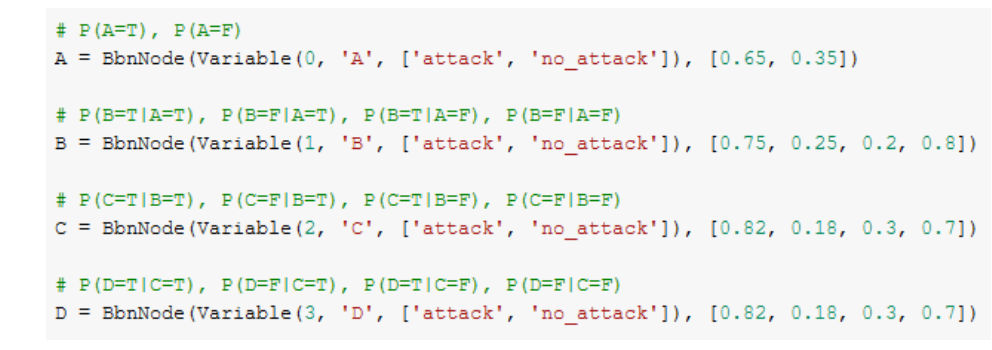
Figure 9. Probabilities of simulated smart home scenario using Bayesian networks.